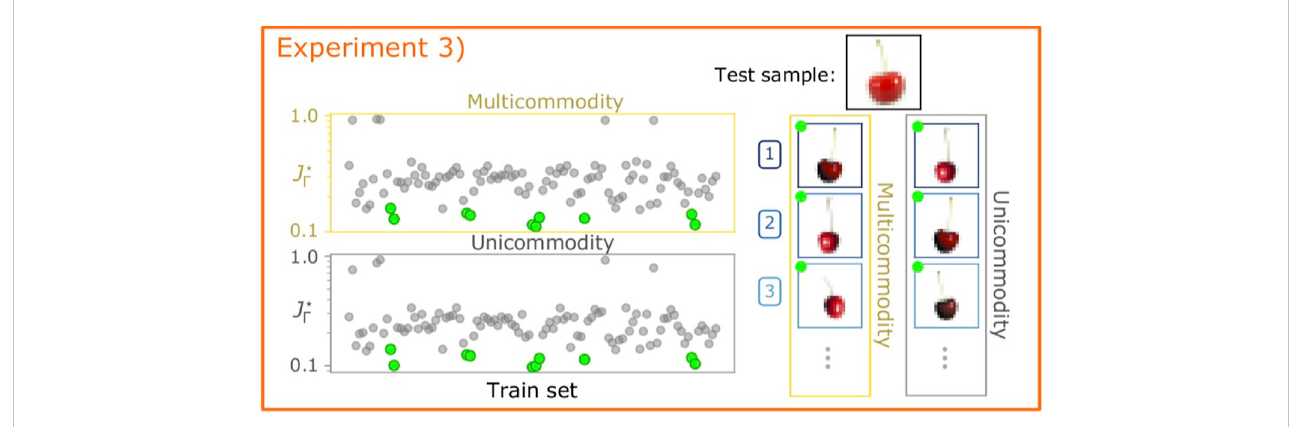
will correspond to a correctly classi fi ed sample (respectively, for orange and red). We further mark the yellow, orange, and red minima in green if the test and train labels correspond, i.e., the marker ’ s and background colors are the same, and in red otherwise. Train and test samples are also in Figure 3. The multicommodity dynamics correctly label each test image. In contrast, unicommodity dynamics fails at this task, labeling a melon as an apricot. This suggests that the multicommodity approach is able to use the color information in datasets where this feature is more informative than others, e.g.,